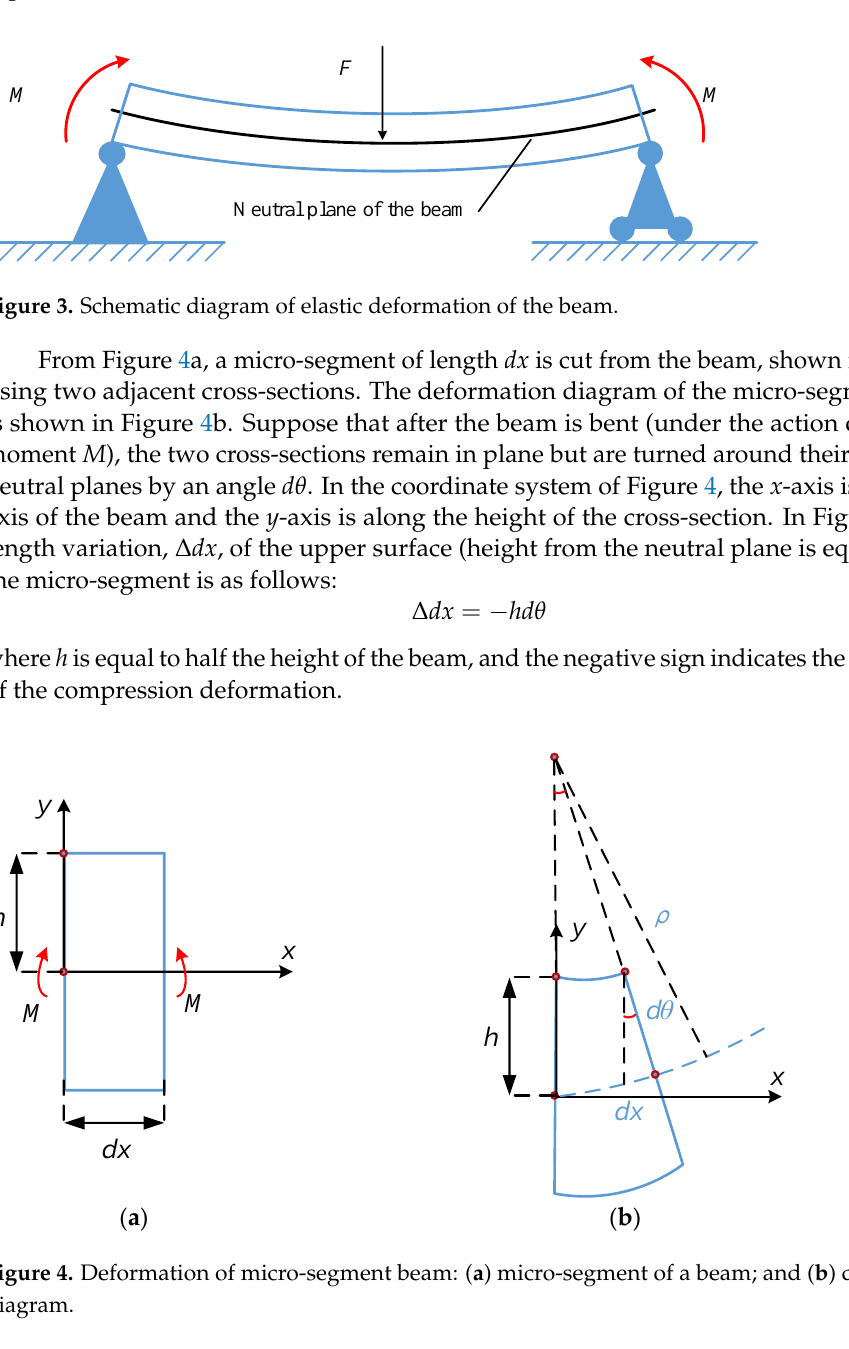
Figure 2. The working principle diagram of the SAW yarn tension sensor.